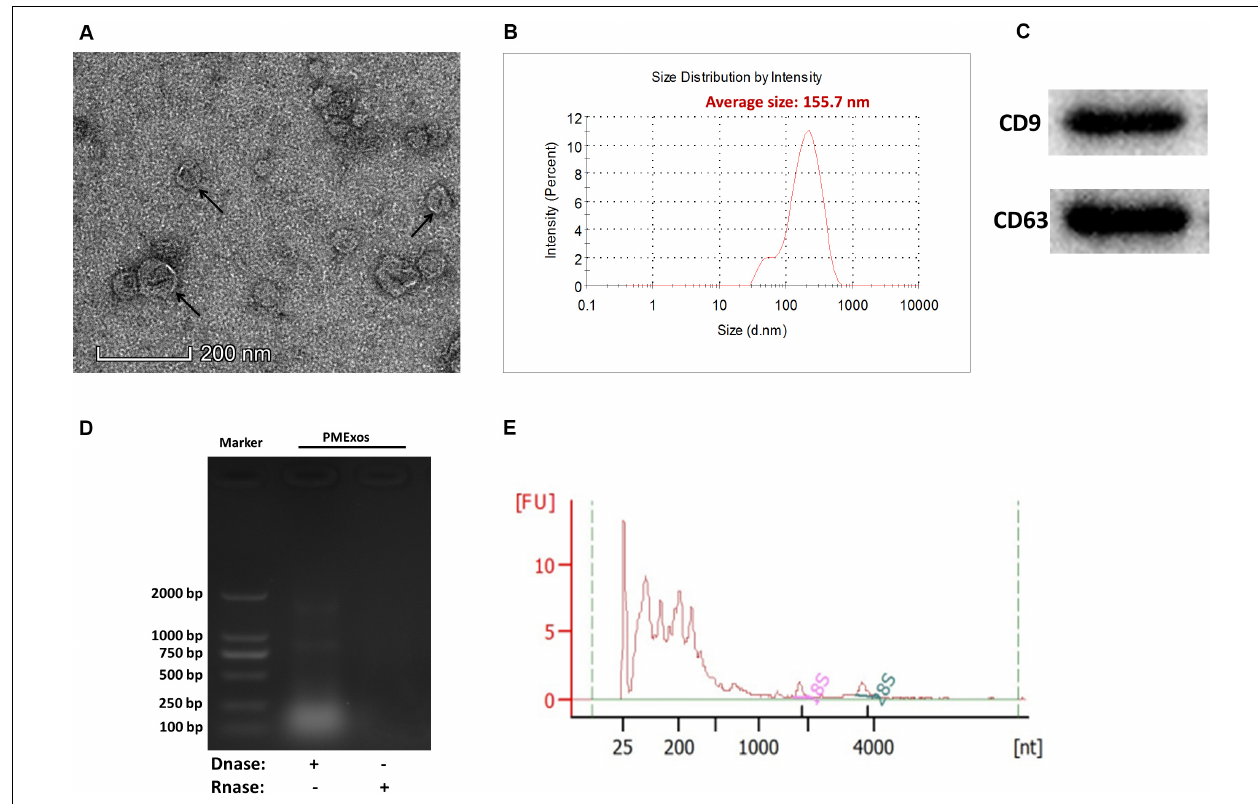
FIGURE 1 | Characterization of porcine milk exosomes. (A) Transmission electron microscopy analysis of porcine milk exosomes. The arrows indicate “milk exosomes.” (B) Size distribution analysis of porcine milk exosomes. (C) Porcine milk exosome proteins resolved by sodium dodecyl sulfate-polyacrylamide gel electrophoresis and analyzed by Western blot (two positive markers, CD9 and CD63). (D) Agarose gel analysis of RNA extracted from porcine milk exosomes. (E) RNA sample of porcine milk exosomes analyzed by Agilent Bioanalyzer